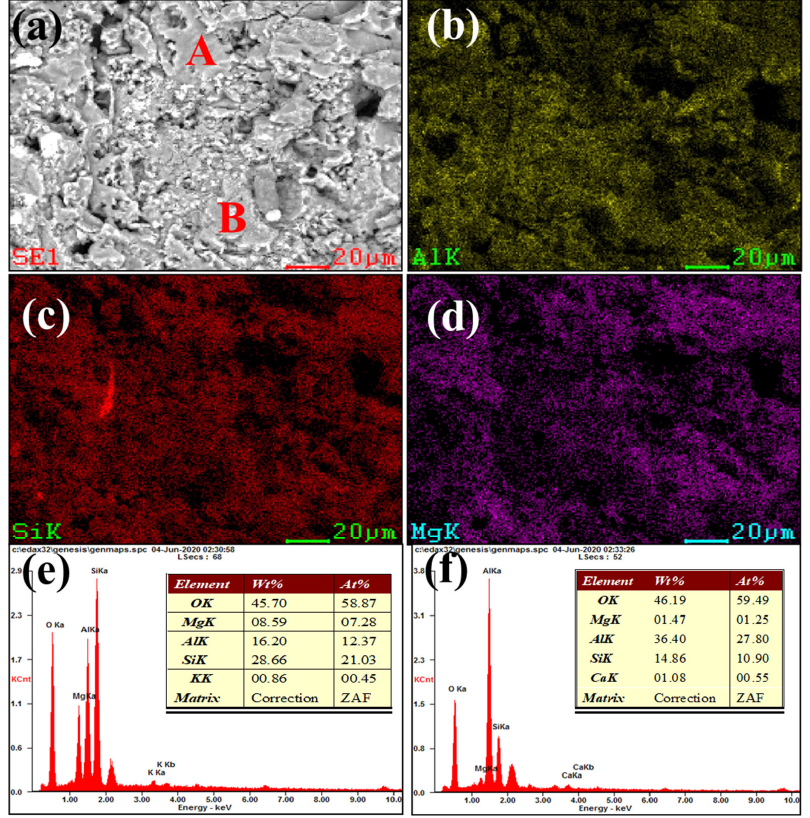
Figure 3. SEM and EDS mapping photos of a section of new saggar. ( a ) SEM image of a sample magnified 1600 times; ( b ), ( c ), and ( d ) EDS mappings of Al, Si, and Mg elements, respectively, in ( a ). ( e ) and ( f ) EDS images of positions A and B, respectively ( a ).